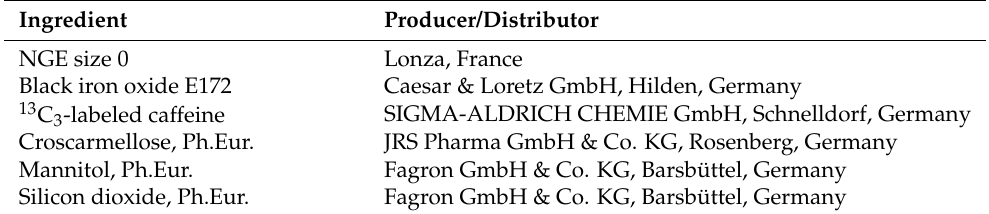
Table 1. Ingredients of the investigated